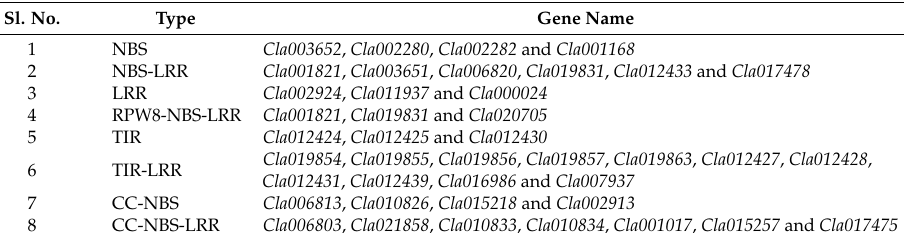
Table 3. Classification of the 44 Citrullus lanatus NBS-encoding genes.